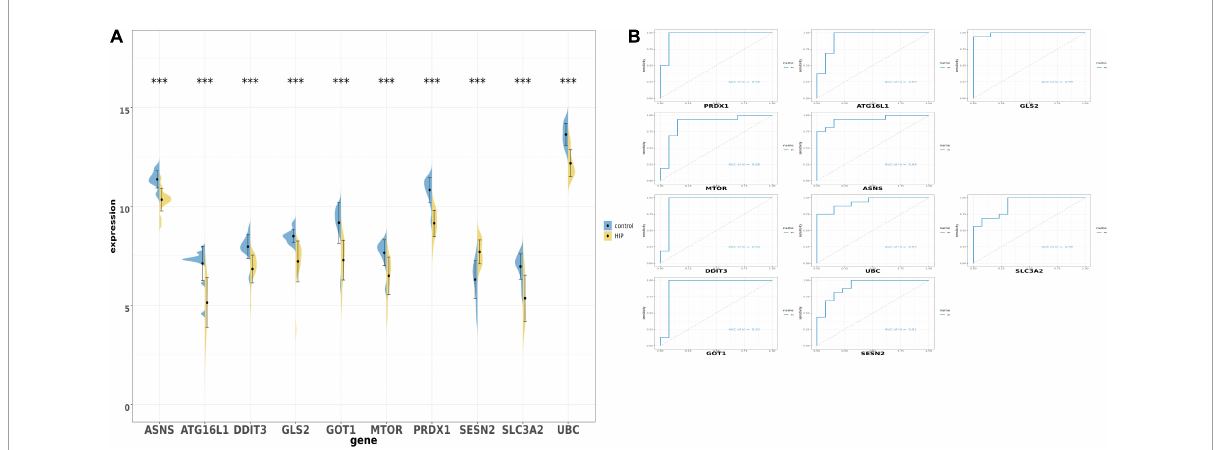
FIGURE4 The boxplot and violine plot of the expression levels of the top 10 ranked ferroptosis-related differentially expression genes (DEGs), aimed at finding the significance and the ROC curve to illustrate the diagnostic value of ferroptosis-related DEGs by monofactor analysis. (A) Expression of the 10 ferroptosis-related genes compared with the non-AD group within the hippocampus region in AD in the combined with GSE5281 and GSE9770 datasets. (B) The AUC in the top 10 ranked ferroptosis-related genes in ROC curve in the set combined with GSE5281 and GSE9770. HIP, hippocampus region in Alzheimer’s disease; ***, p < 0.001. AUC, Area under the curve.